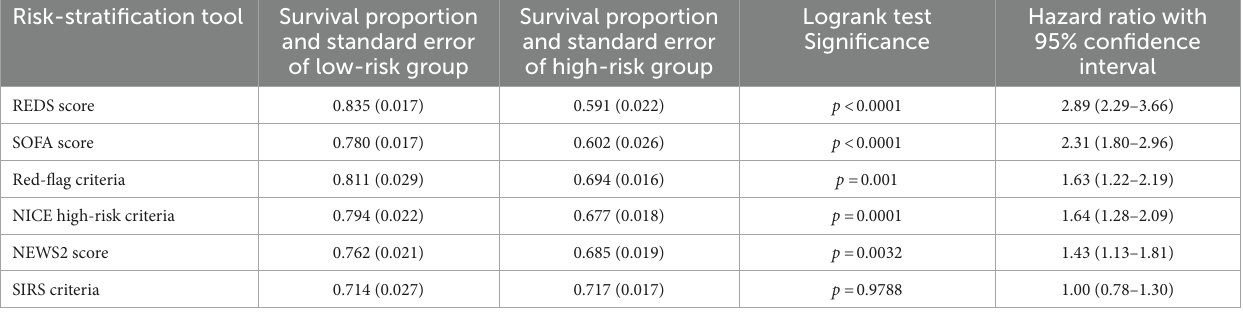
TABLE 2 Survival proportion at 180 days by risk-stratification tool.